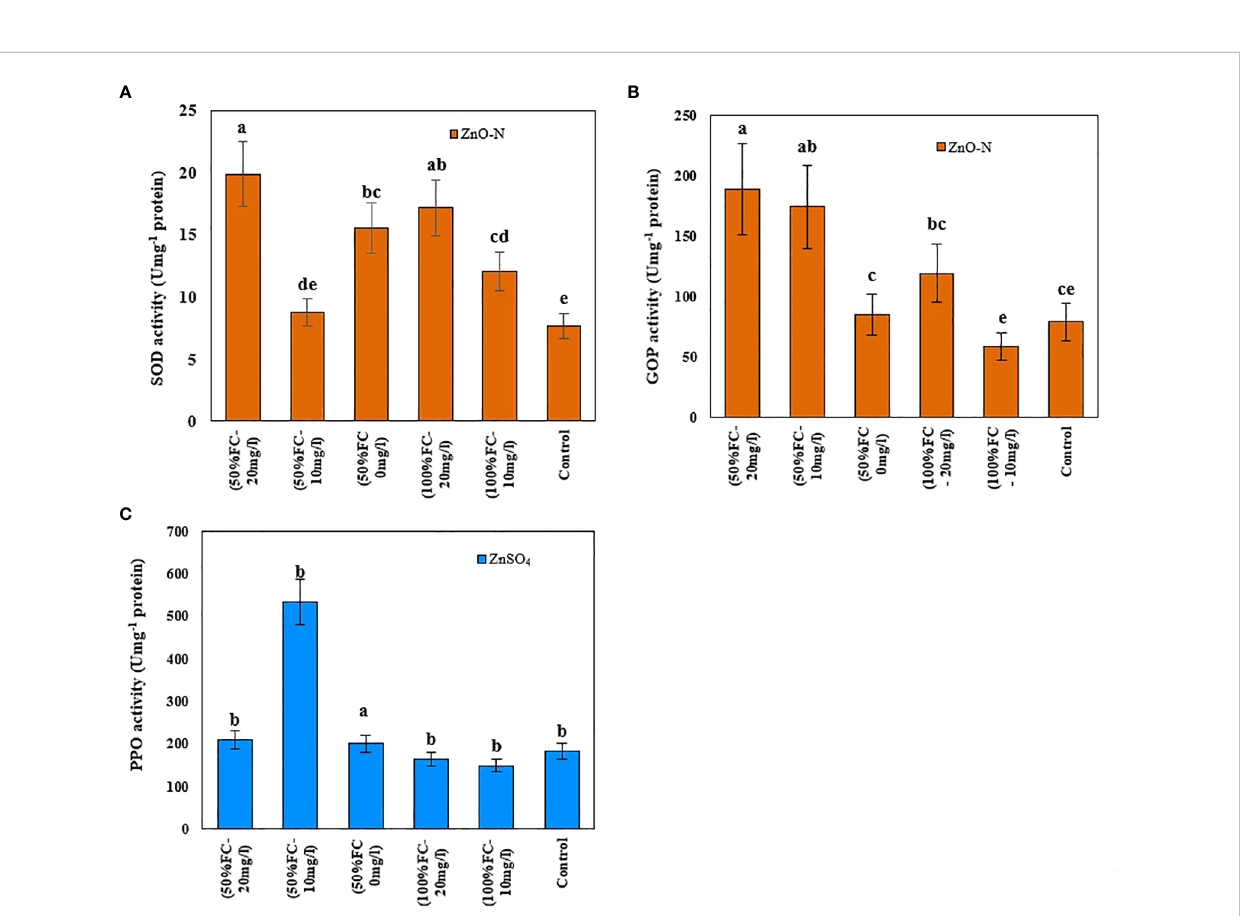
FIGURE 5 Impact of ZnO-N on SOD (A) and GPO (B) ; ZnSO 4 on PPO (C) in D Kotschyi under Drought Stress. Means followed by the same letters did not differ signi fi cantly at p ≤ 0.05, n =